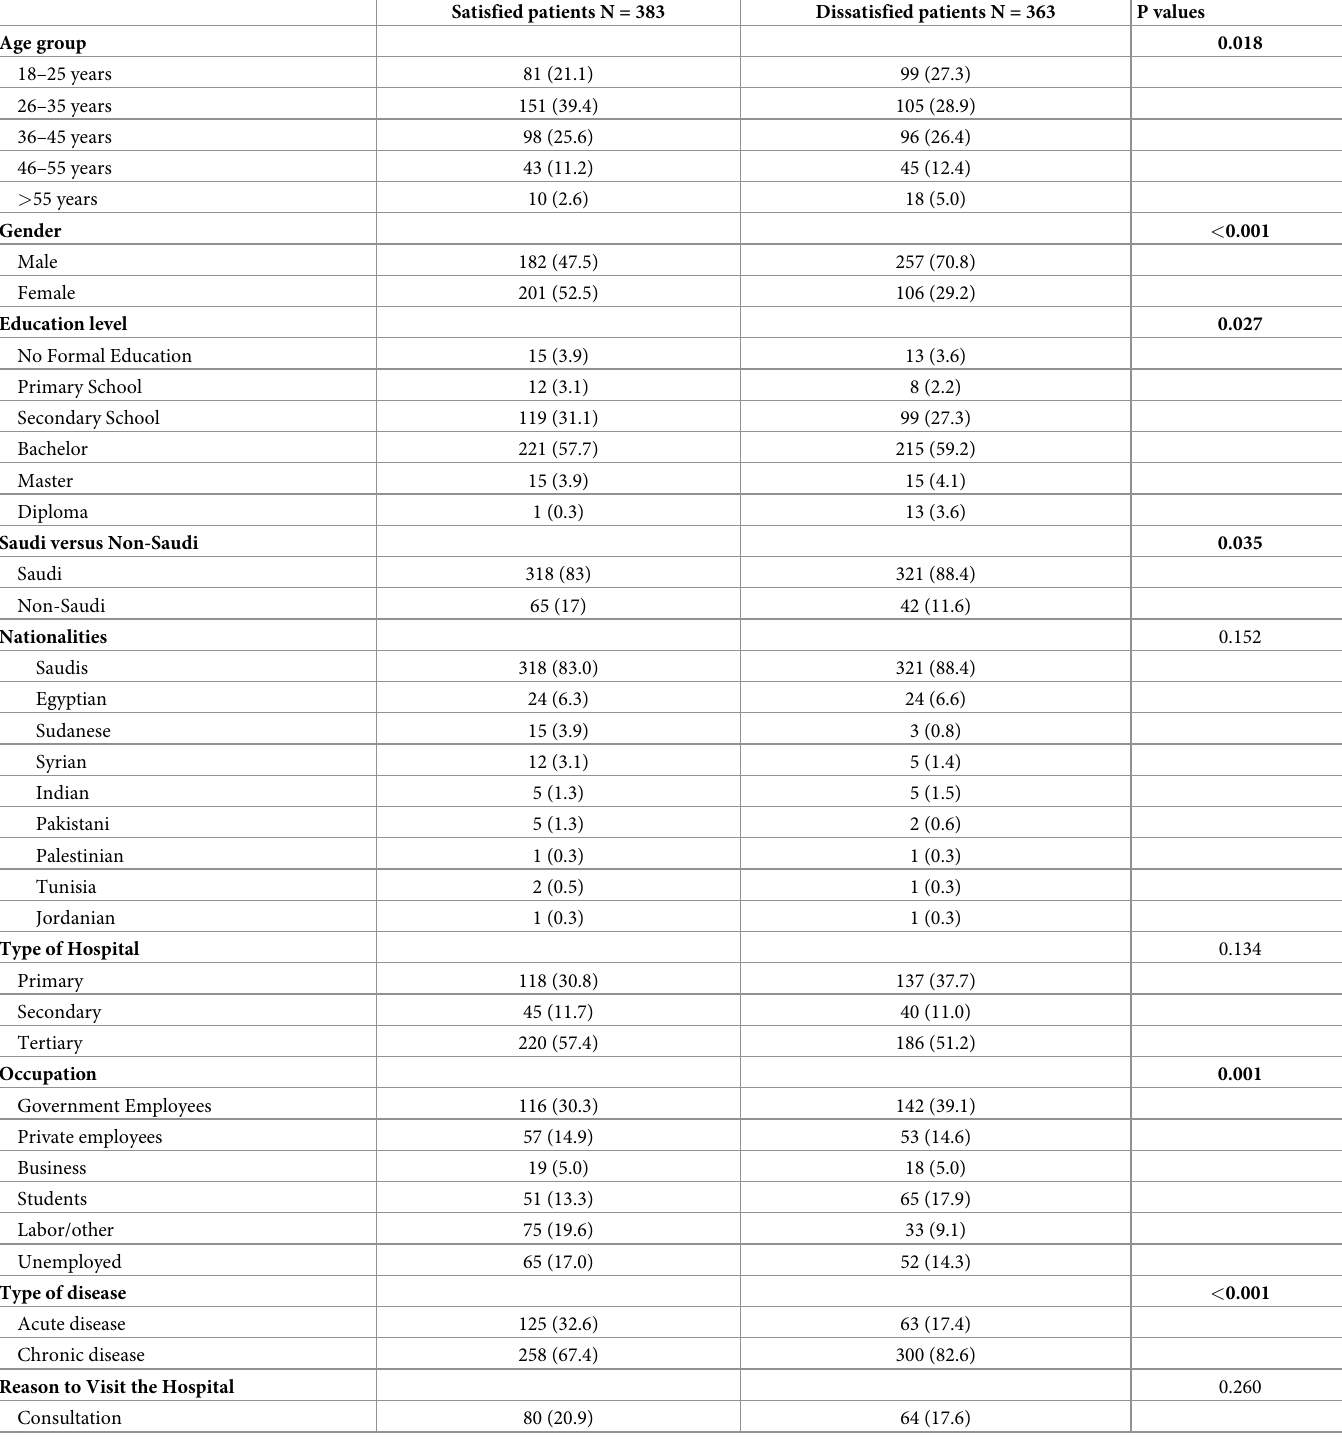
Table 4. Factors associated with satisfaction status for pharmacy facilities and services among